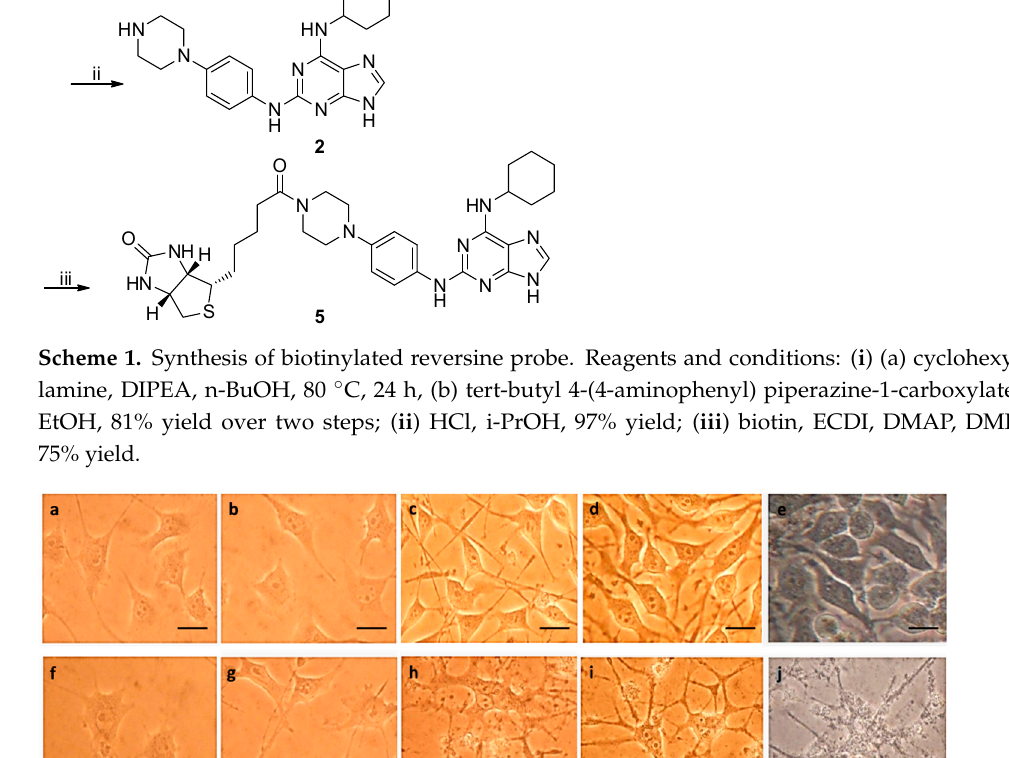
Figure 1. Morphological changes of MRC-5 cells induced by aza-reversine 2 (100 nM per well). ( a – e ) Control cells that were treated with DMSO (<1%) after: ( a ) 0, ( b ) 24, ( c ) 48, ( d ) 72, ( e ) 96 h; ( f – j ) cells that were treated with 2 (100 nM/well) after: ( f ) 0, ( g ) 24, ( h ) 48, ( i ) 72, ( j ) 96 h. All images were taken using optical microscopy with 40 × magnification. Scale bar: 0.5 μ m.